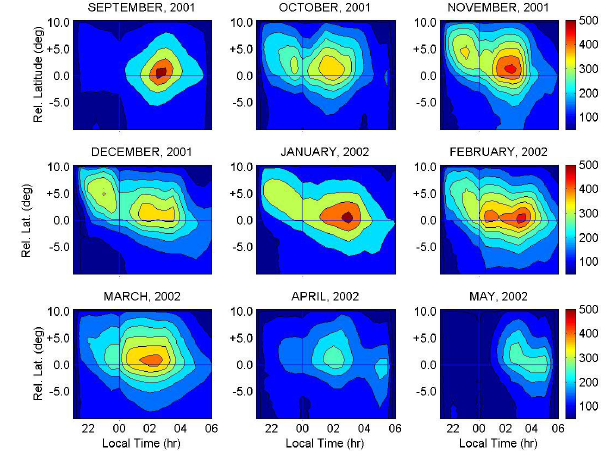
Fig. 1. Latitude-local time contour plots of O[ 1 D] 630-nm bright- ness over Asmara. Vertical axes place Asmara (15.4 ◦ N geographic or 7 ◦ N dip) at 0 ◦ latitude, marked by horizontal line. Vertical line marks local midnight, 00:00